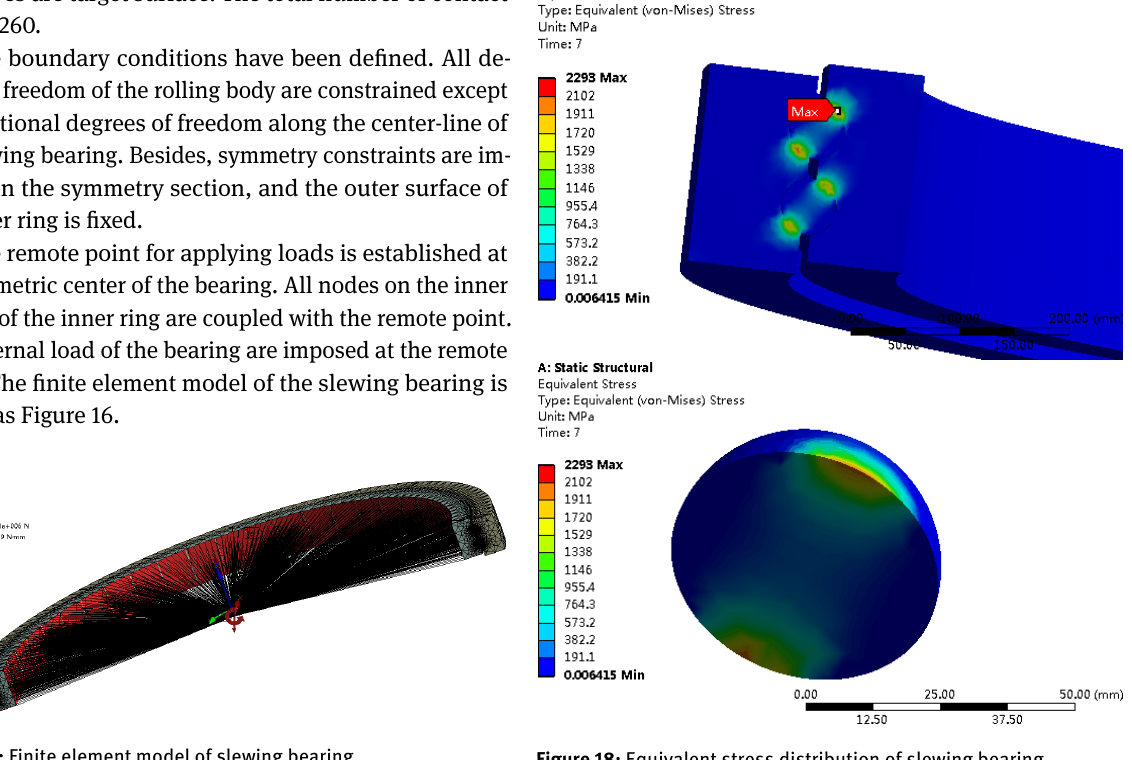
The contacts between rolling elements and grooves of rings are set to frictional contact type based on the in- teraction. And the friction coefficient is 0.04. The rolling elements surface are set to contact surface and the surface